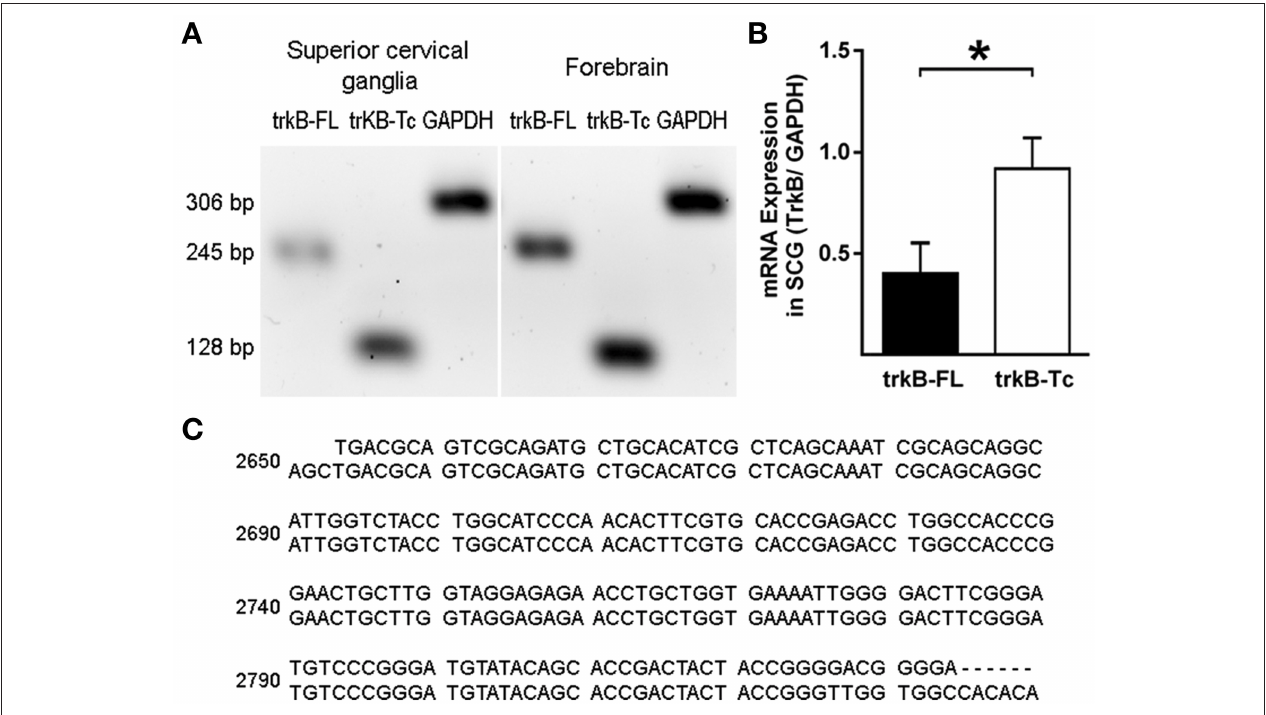
FIGURE 6 | RT-PCR analysis of TrkB expression in the SCG and forebrain. Total mRNA was extracted from the SCG and forebrain (used as a control), and semi-quantitative RT-PCR was performed. (A) Expression of trkB-Fl and trkB-Tc in the SCG and forebrain. GADPH was used as a reaction control. (B) Graph showing differences in the expression of TrkB-Tc and TrkB-Fl mRNA; * p < 0.05. (C) Sequences showing the alignment of RT-PCR products (upper lines) with the published GenBank sequence (https://www.ncbi.nlm.nih.gov/genbank/), confirming identity as TrkB-Fl (score 97–99%). n =